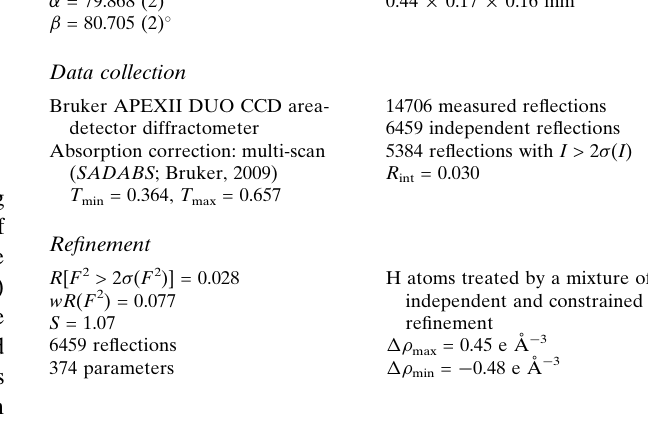
Bruker APEXII DUO CCD area- detector diffractometer Absorption correction: multi-scan ( SADABS ; Bruker, 2009)